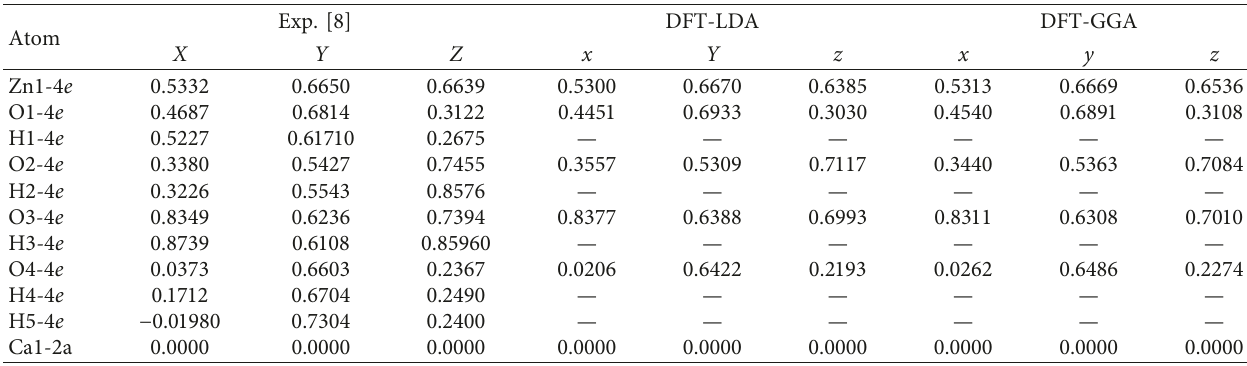
Table 2: Experimental and calculated coordinates of Wyckoff positions in qatranaite single crystal. Atom